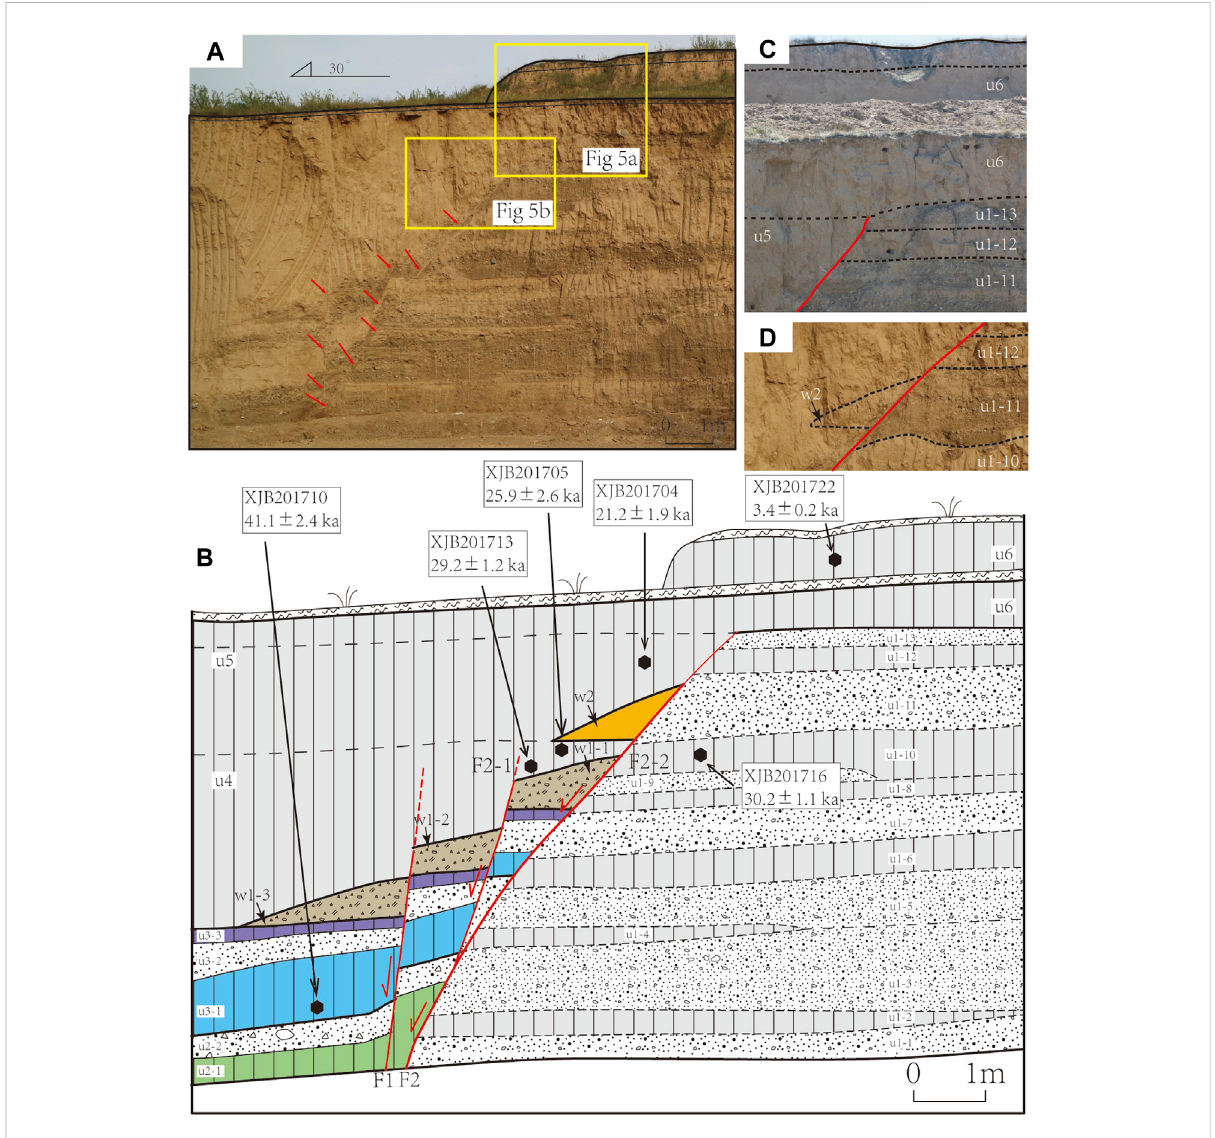
FIGURE 5 Photograph mosaic (A) and the interpreted map (B) of the Xujiabao pro fi le. U denotes the stratum unit, and black lines show the stratigraphic contacts between units or subunits. Red lines show the fault planes. Small black fi lled hexagons show the locations of OSL samples, labeled with sample numbers and their ages (Table 2). (C, D) , Local enlarged photographs, showing the details of the trench exposures; see locations in (A)